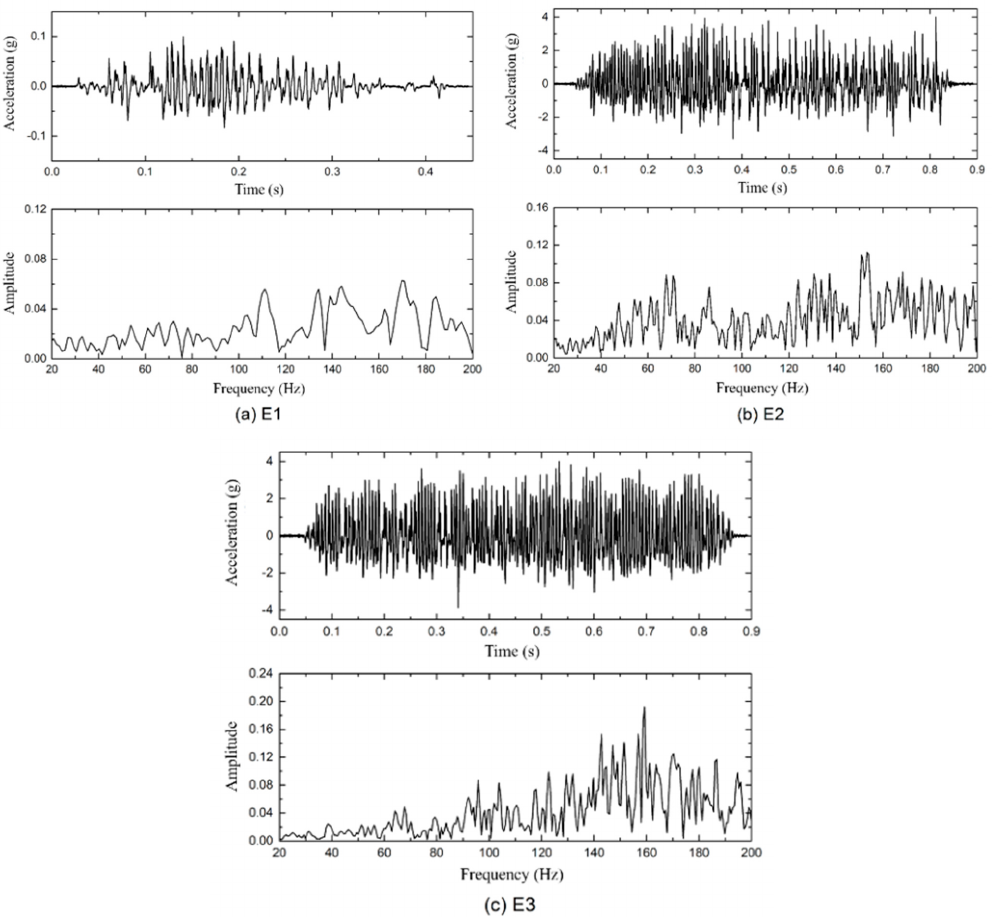
Figure 5. Actual input ground motions into the shaking table:( a ) E1; ( b ) E2; ( c ) E3.